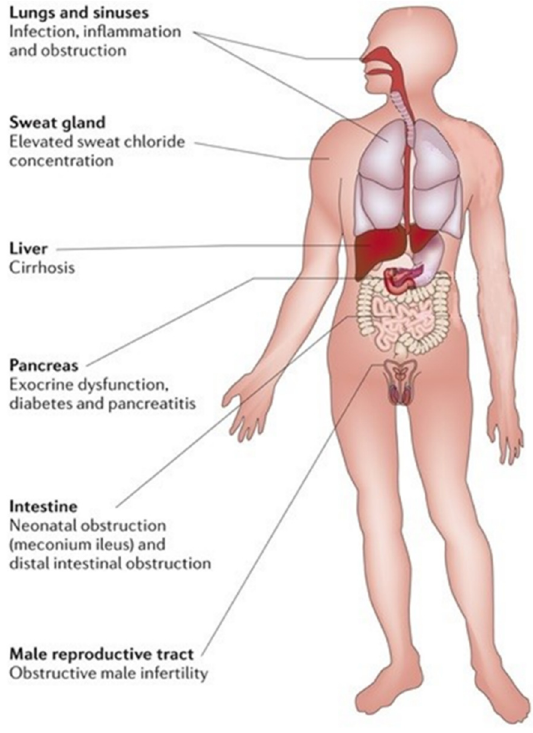
Figure 1. Clinical manifestations of cystic fibrosis.